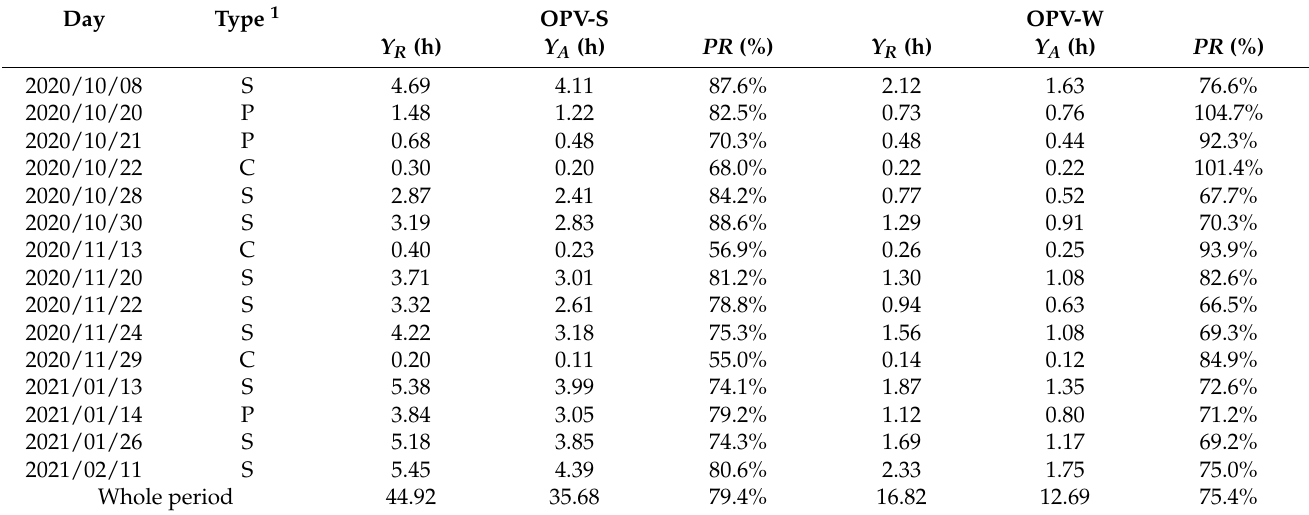
Table 3. Y R , Y A , and PR for the two OPV modules under